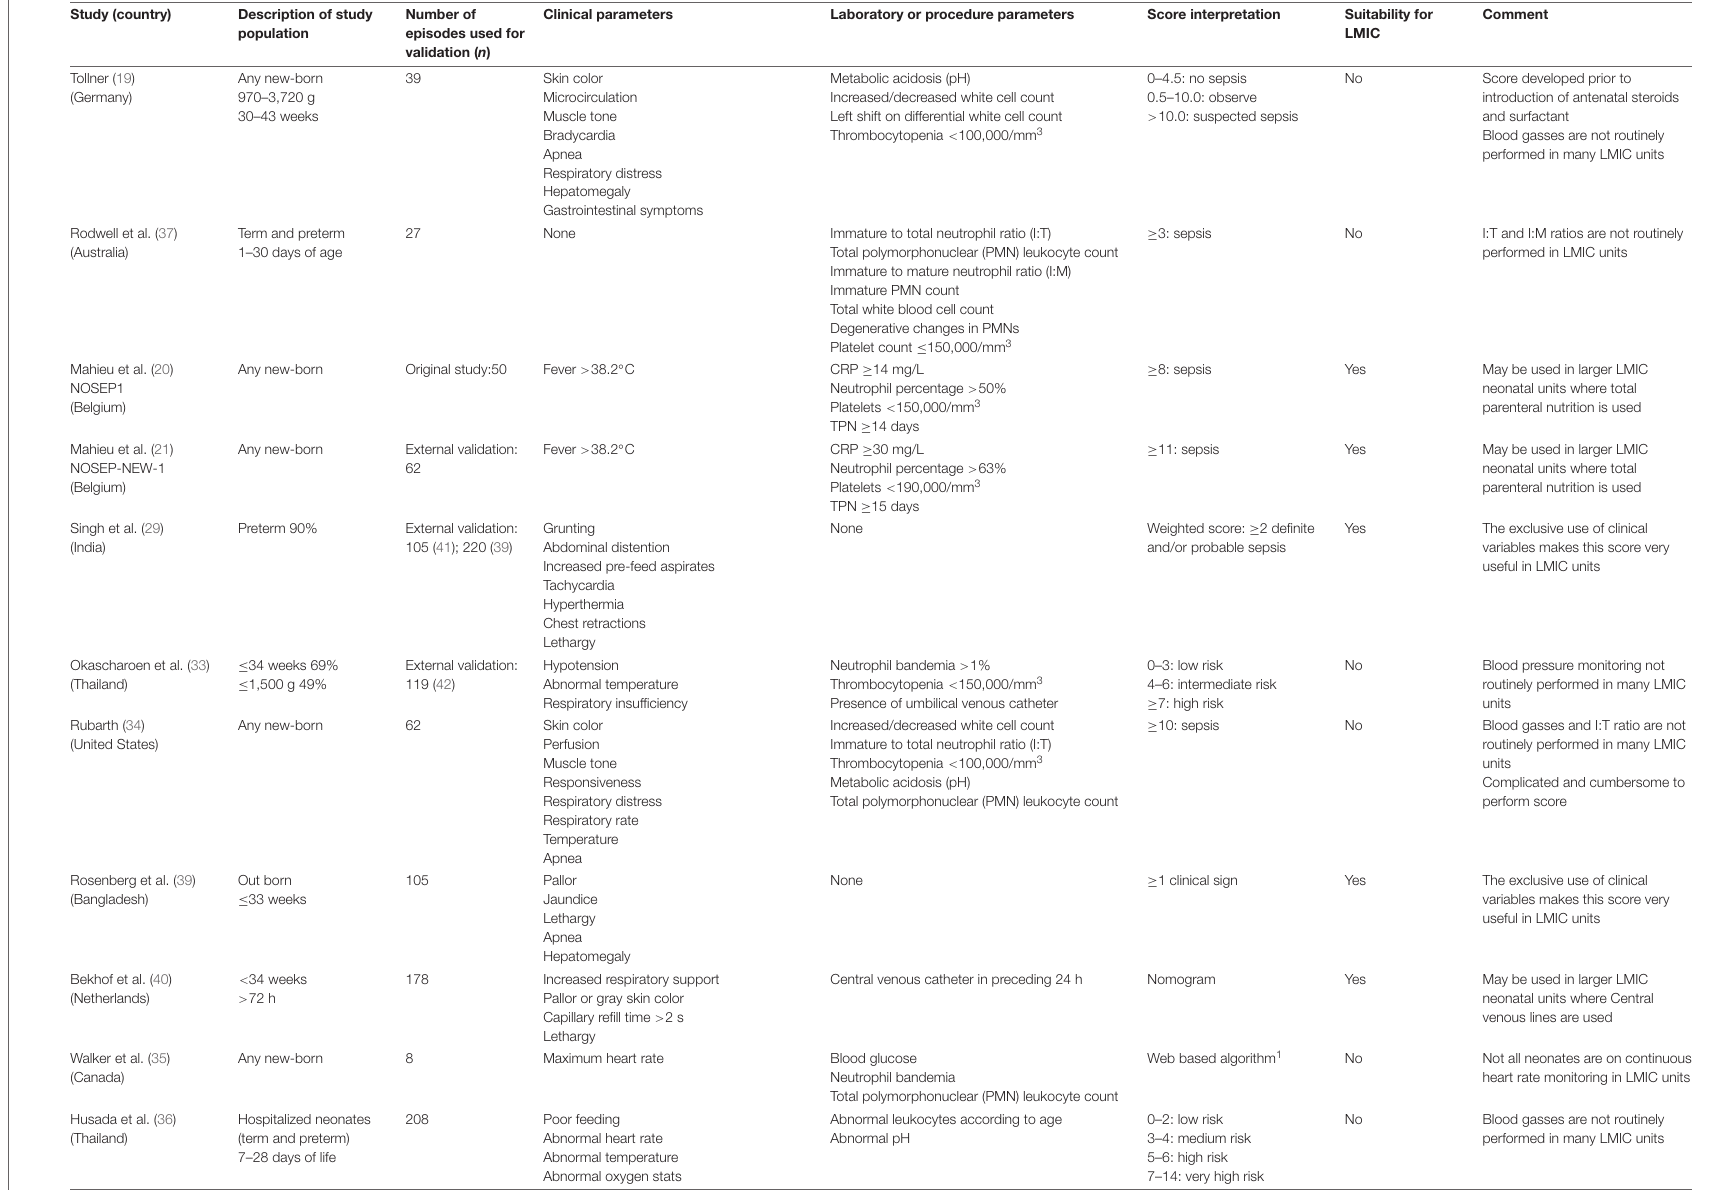
TABLE 1 | Description of existing infection prediction scores for hospital-acquired infection in neonates. Study (country) Description of study population